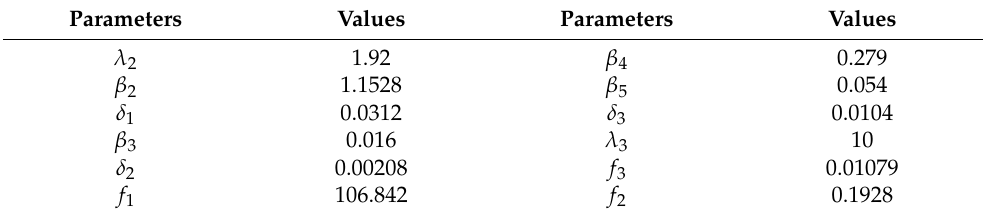
Table 1. Dimensionless parameters of the equivalent model and the